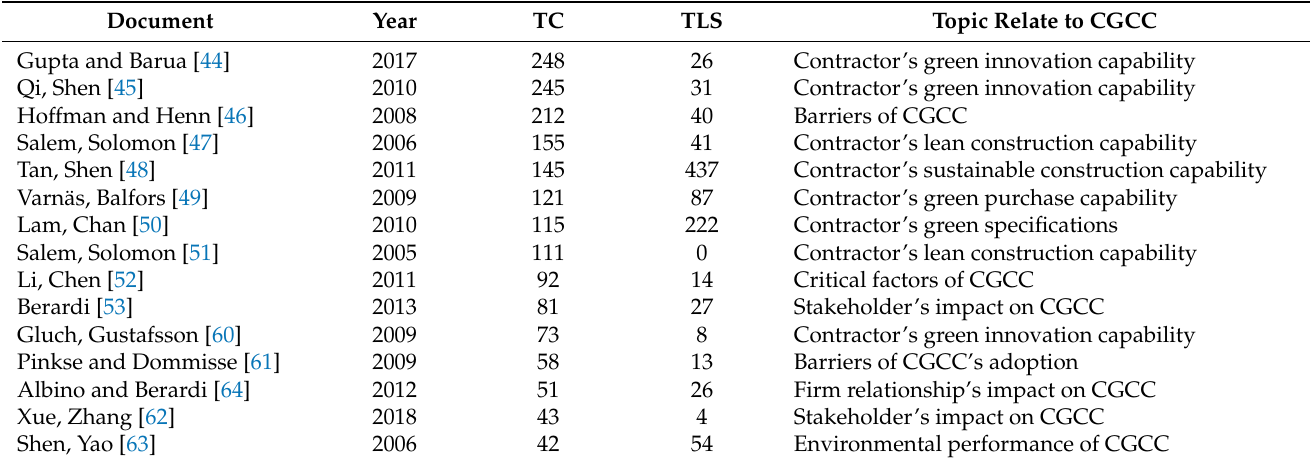
Table 3. List of publications with the highest impact in CGCC.